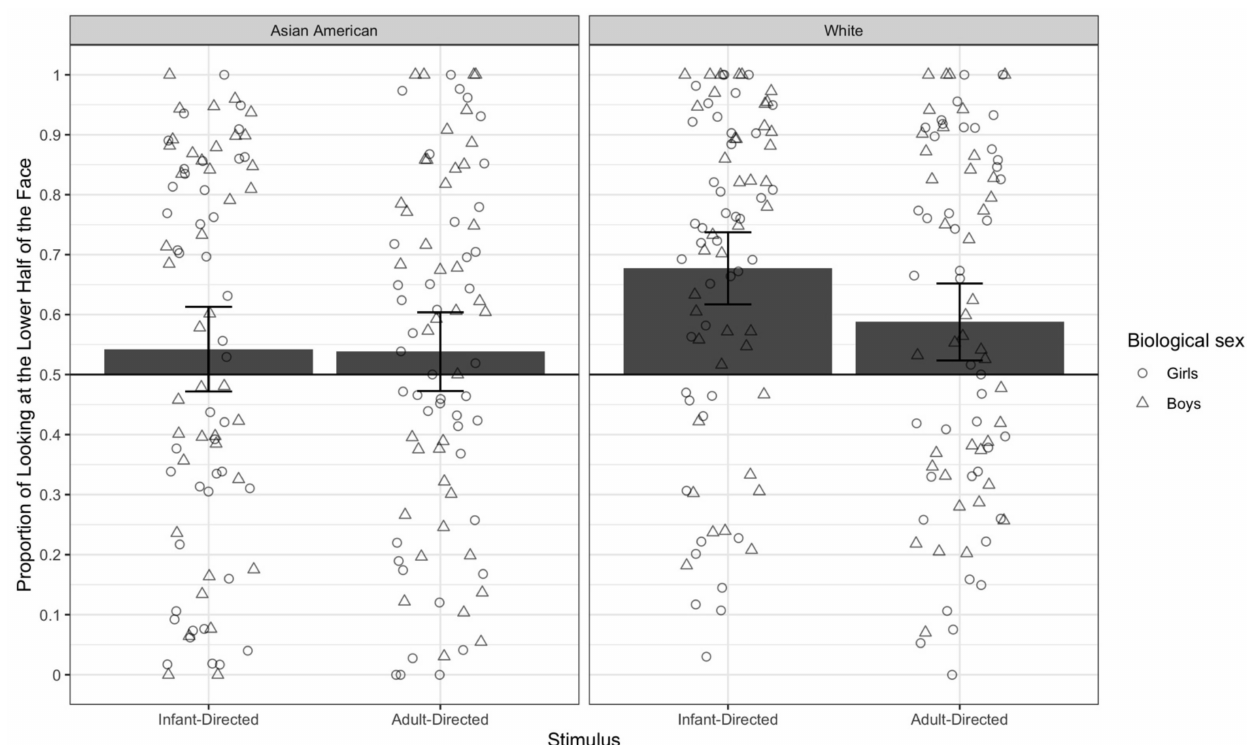
Figure 3. Mean preference for the lower half of the face for each stimulus type, collapsed across all infants. The line bisecting the graph at 0.50 represents chance, or equal looking at the upper and lower regions. Each open circle represents the score for an individual infant. Error bars represent 95% confidence intervals. The biological sex of each infant is indicated by the shape of the